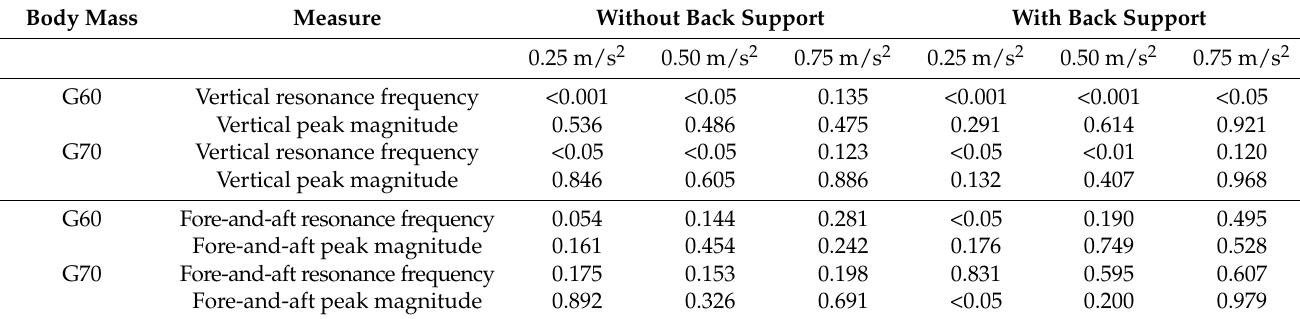
Table 6. p -values obtained from paired t -test of the primary resonance frequency and peak STHT magnitudes for the two gender groups of comparable body mass (60 and 70 kg) for the two sitting and three excitation conditions.